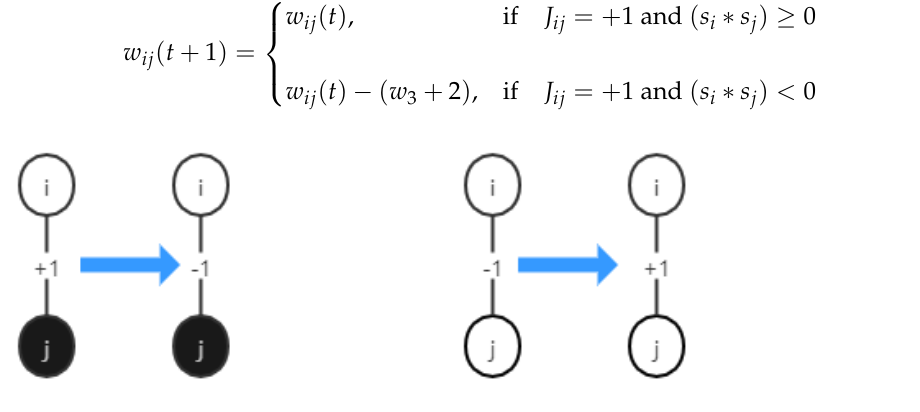
Figure 4. Evolutionary rules of edge = + 1 and edge = − 1.